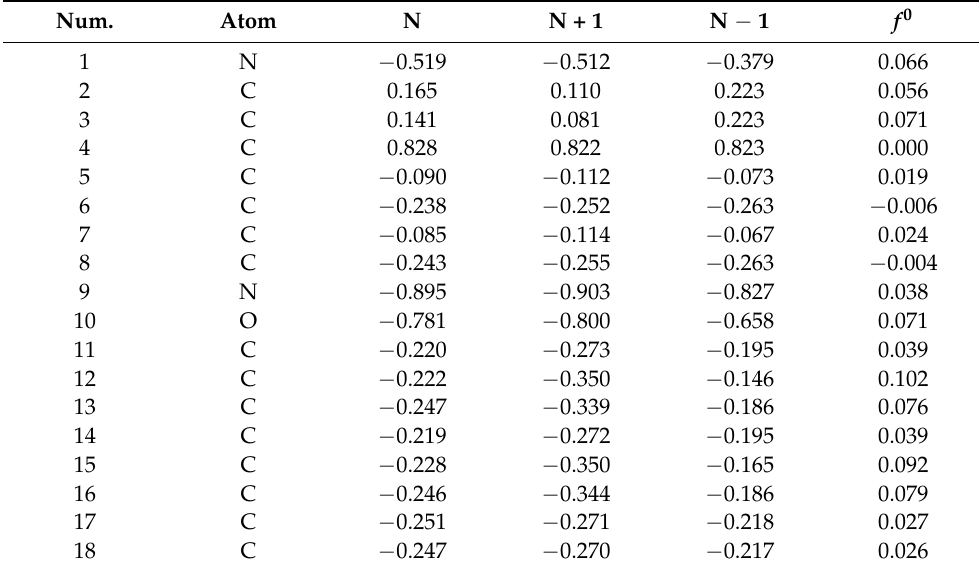
Figure 5. The suggested degradation pathway of CBZ by Bi 2 WO 6 under visible light irradiation (The detail of product A–J was displayed in Table S1). Table 1. Condensed Fukui index ( f 0 ) distribution by NPA on